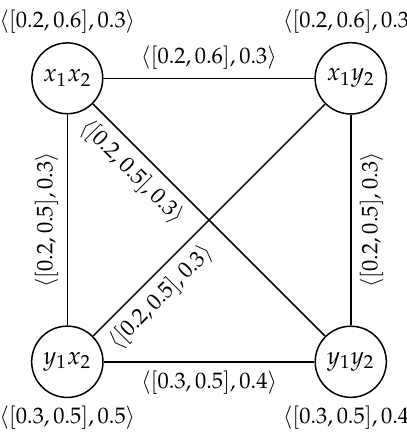
Figure 8. The composition of G 1 and G 2 .